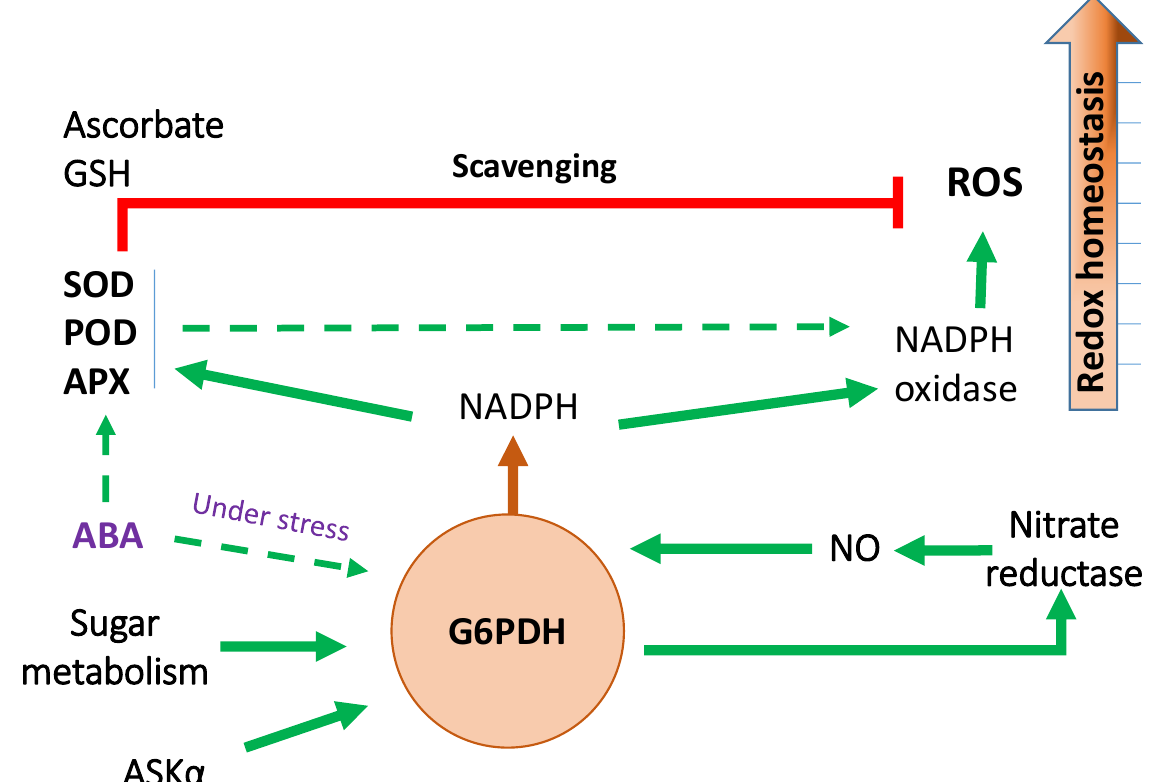
Figure 4. Regulatory network of G6PDH in the context of plant responses to abiotic stress. The NADPH provided by cytosolic G6PDH activity is required both for ROS production by NADPH oxidase and for ROS scavenging by activation of GSH ascorbate cycle. The working model proposed that G6PDH plays a pivotal role in redox homeostasis, ROS signaling and NO cascade signaling. ASK α , Arabidopsis thaliana glycogen synthase kinase3 (GSK3)/SHAGGY-like kinase; ABA, abscisic acid; APX, ascorbate peroxidase; POD, peroxidase; SOD, superoxide dismutase; GSH, reduced glutathione; ROS, reactive oxygen